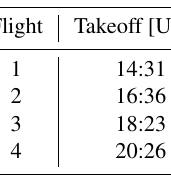
Table 1. Takeoff and landing time for each flight of the M 2 AV on 2 July